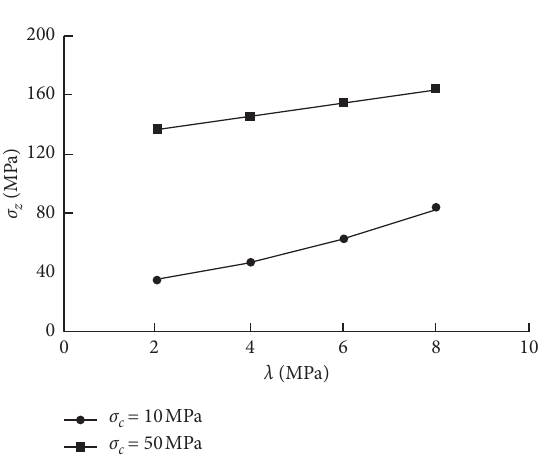
Figure 11: Correlation between bearing capacity and λ .